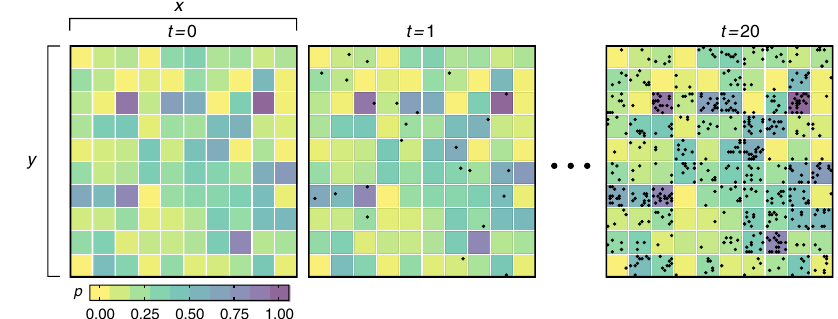
Fig. 9 Spatiotemporal event generator. An example of a data set constructed considering a grid Gr 10×10 , an exponential probability distribution (cells' colors), and a time length T = 20. Each grid represents all the generated events (black dots) until